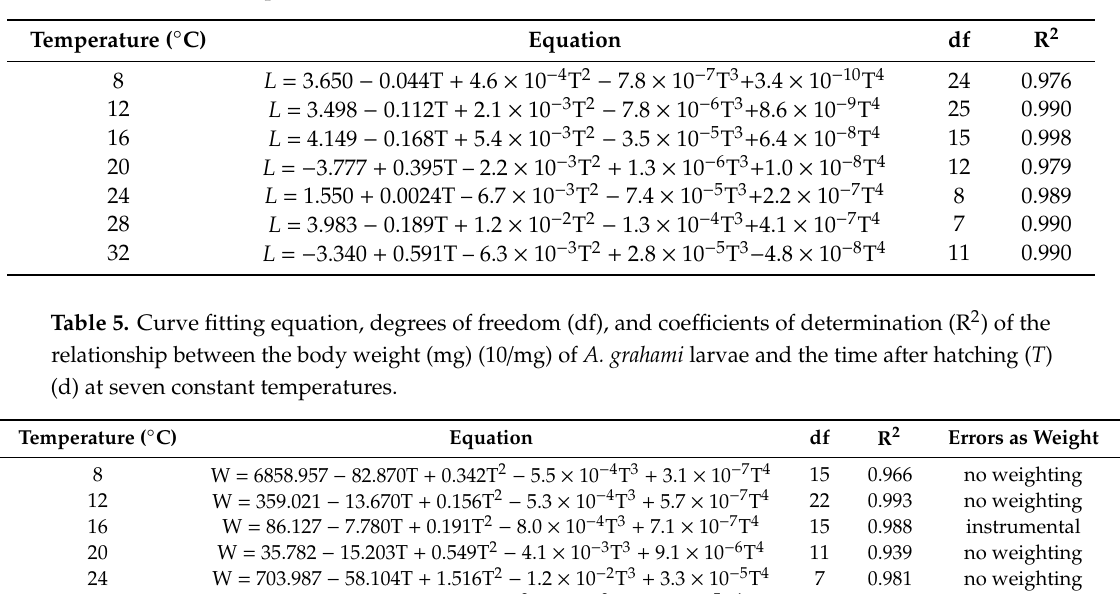
Table 4. Curve fitting equation, degrees of freedom (df), and coe ffi cients of determination (R 2 ) of the relationship between the body length ( L ) (mm) of A. grahami larvae and the time after hatching ( T ) (d) at seven constant temperatures.